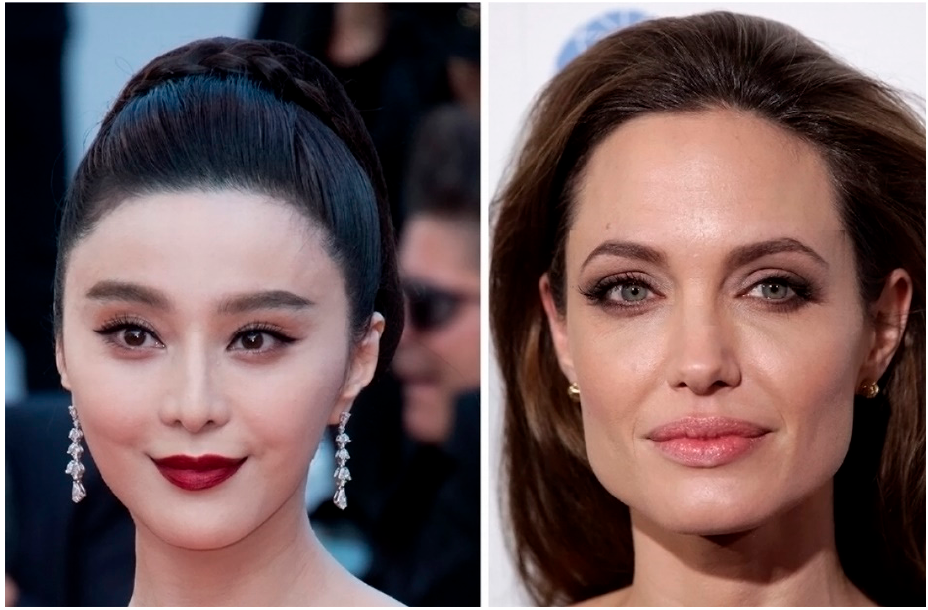
Figure 2. Images of Fan Bingbing ( left ) and Angelina Jolie ( right ) [4]. Asians, including those with Fitzpatrick skin phototypes III and above, show fewer age-related rhytids than Caucasians. This has been attributed to a thicker dermis, increased fat above and deep within the superficial muscular aponeurotic system, and dense fat and fibrous connections between the superficial muscular aponeurotic system and deep parotid masseteric fascia, based on anecdotal evidence from cadaver dissections [23]. Some muscles, such as the corrugator supercilii, have a lesser mass in Asians than Caucasians; the corrugator supercilii are also often shorter, thinner, and less hyperdynamic. Variations in the frequency of certain facial expressions, such as frowning, are believed to provide a genetic and cultural foundation for these distinctions [24]. In contrast,